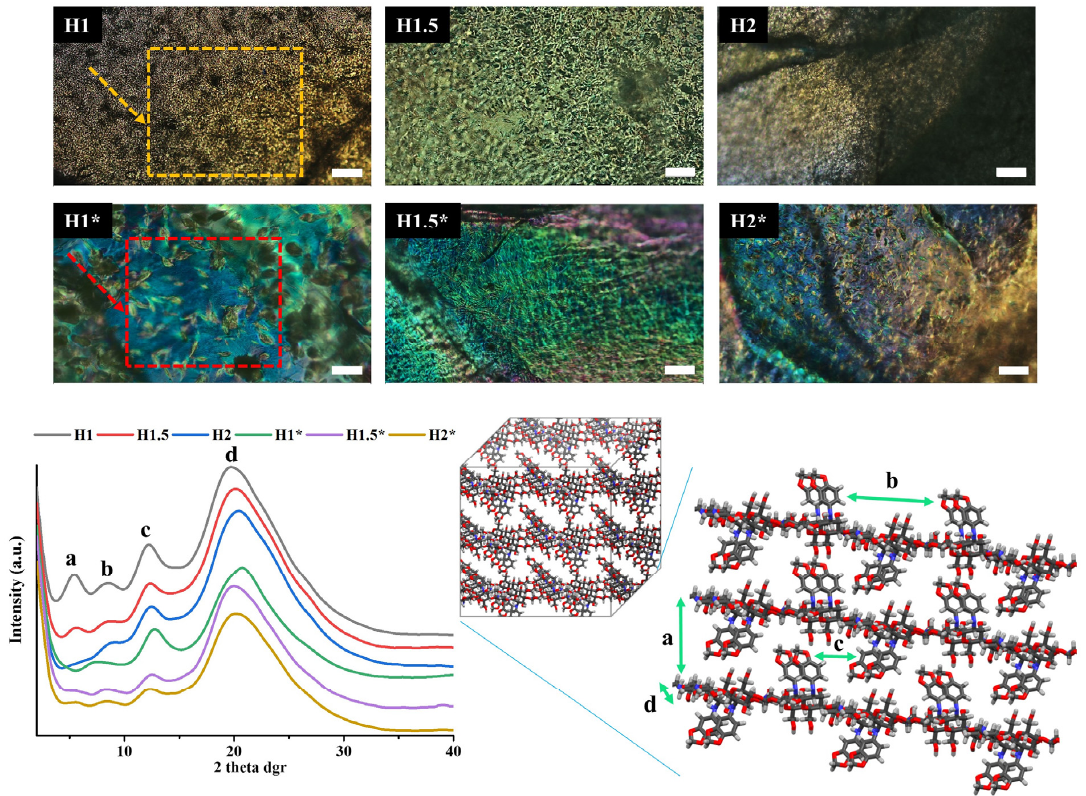
Figure 2. Diffractograms of the reference xerogels and formulations and POM images for the reference hydrogels and the formulations (scale bar 50 µ m) (a, b, c, d represent the diffraction peaks and the corresponding d -spacings from the Bragg’s law). The regions indicated with arrows indicate strong